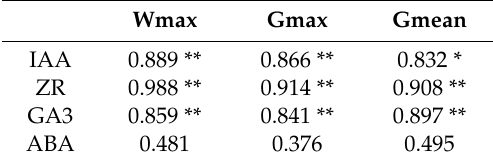
Table 5. Correlation coe ffi cients of mean hormone contents in maize grain with the maximum grain filling rate (Gmax), mean grain filling rate (Gmean), and maximum grain weight (Wmax) of maize. Wmax Gmax Gmean IAA 0.889 ** 0.866 ** 0.832 * ZR 0.988 ** 0.914 ** 0.908 ** GA3 0.859 ** 0.841 ** 0.897 ** ABA 0.481 0.376 0.495 IAA, indole-3-acetic acid; ABA, abscisic acid; ZR, zeatin riboside; GA3, gibberellin 3; Wmax: the final grain weight (mg); Gmax: maximum grain-filling rates; Gmean: mean grain-filling rates. * Significant at the 0.05 probability